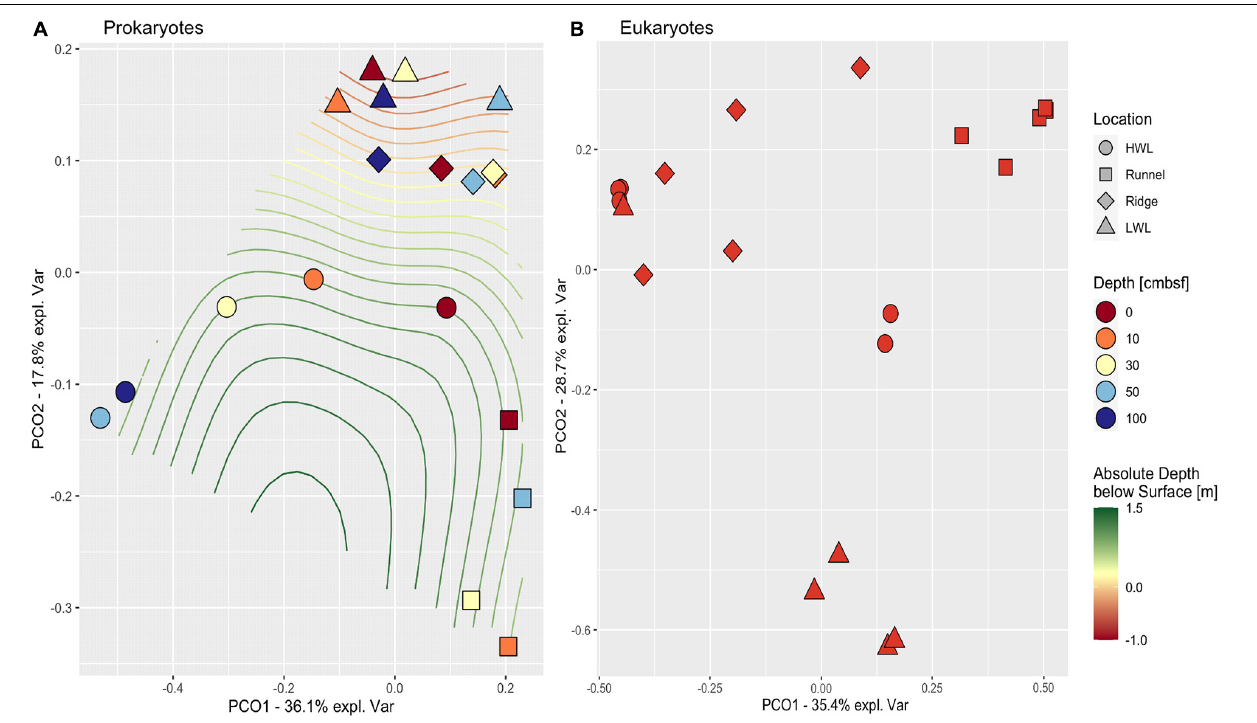
FIGURE 3 | PCoA of prokaryotic (A) and eukaryotic (B) communities. The PCoA plots depict the similarities between samples based on community composition comparing the four locations (symbols) and depths (colors). Absolute depth above or below sea level is indicated by isoclines. Depth is showed in centimeters below sea floor